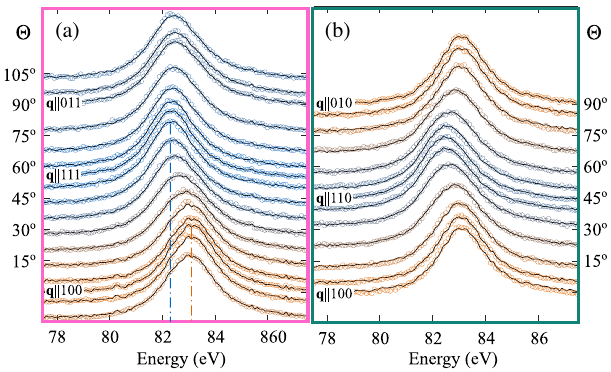
FIG. 2. (a),(b) Stack of the Mn M 1 NIXS spectra acquired for the planes as indicated in Fig. 1(b). The black lines are the result of the fit procedure explained in the